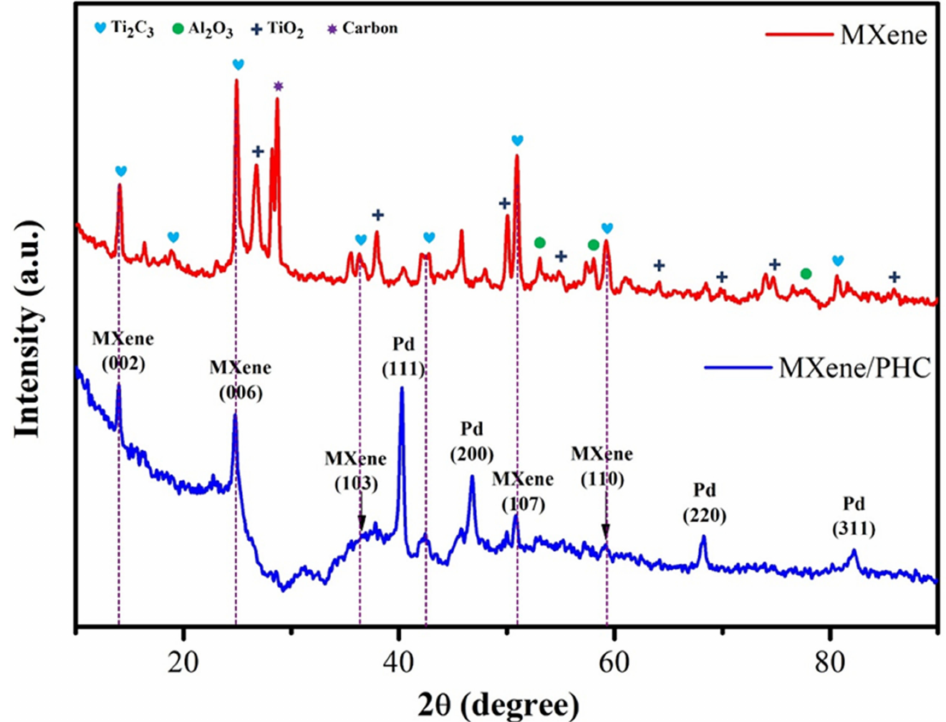
Figure 3. XRD spectra of MXene and MXene/PHC